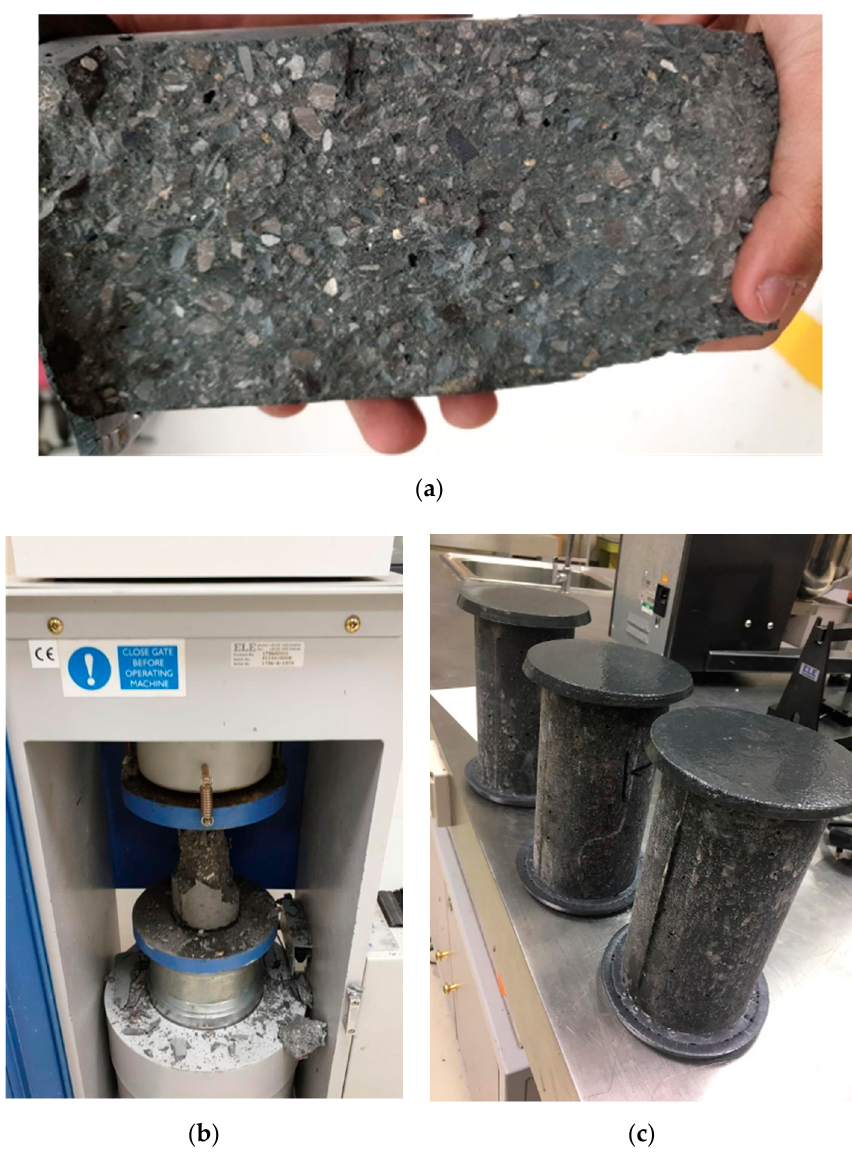
Figure 2. Photographs showing the tests performed on hardened SCC samples: ( a ) Tested SCC samples; ( b ) Sample being tested for its compressive strength; ( c ) Sulfur-capped samples ready to be tested.